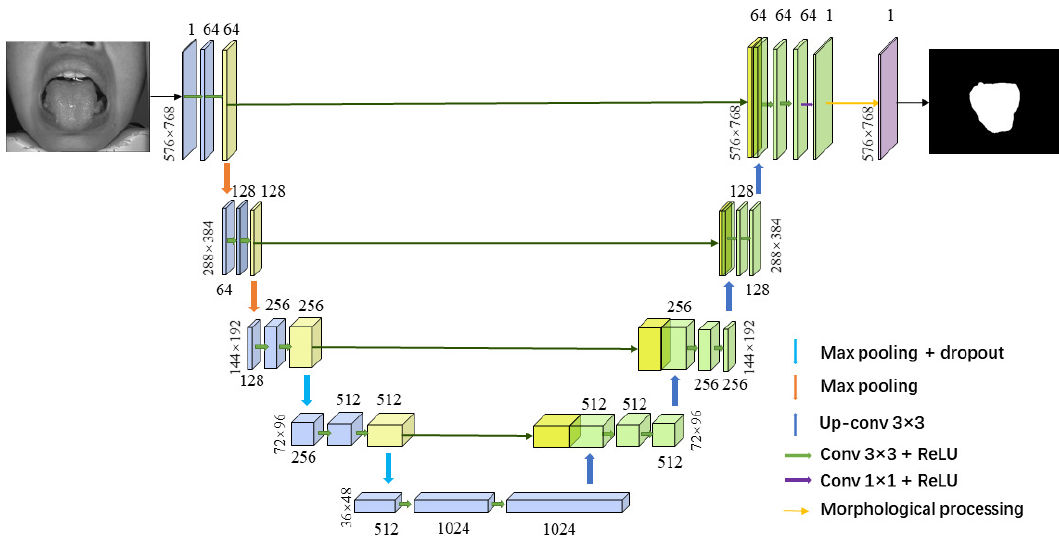
Figure 4. The U-net architecture applied in tongue segmentation. Boxes in yellow are the feature maps which are combined with the corresponding feature maps after up-sampling (green boxes). The morphological processing layer is placed at the end of network.